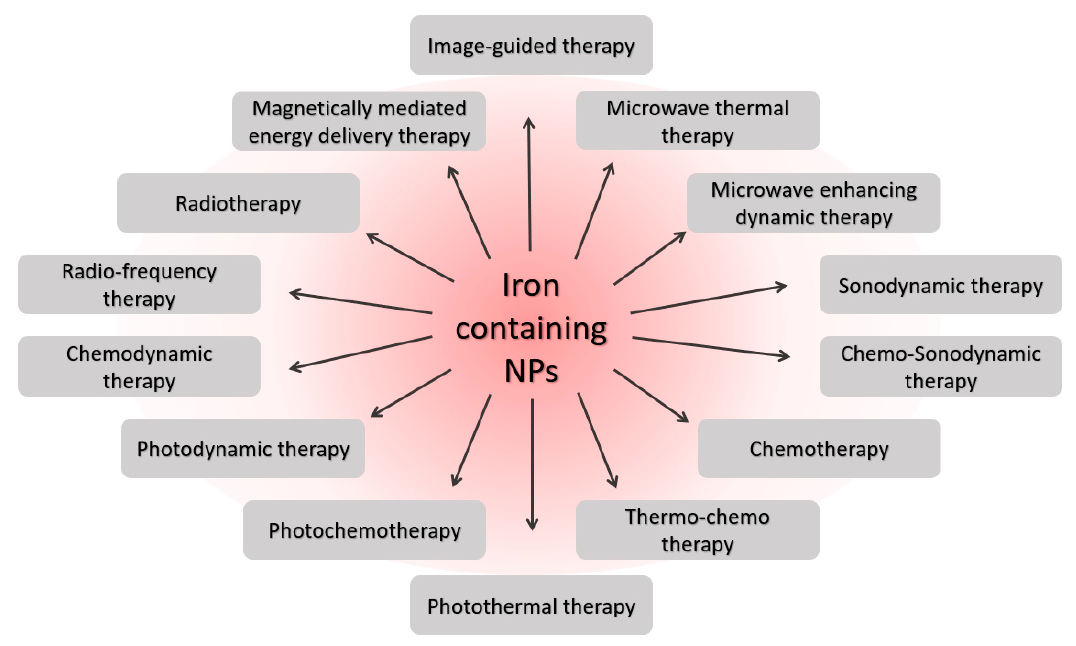
Figure 2. Biomedical therapies involving iron containing nanoparticles.